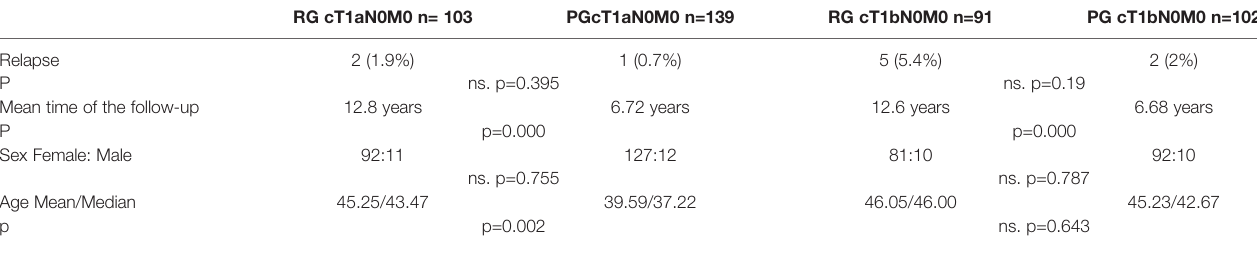
TABLE 7 | Comparison of the incidence of relapses and the mean time of the follow-up and distribution of sex and age in prospective and retrospective groups. RG cT1aN0M0 n= 103 PGcT1aN0M0 n=139 RG cT1bN0M0 n=91 PG cT1bN0M0 n=102 Relapse 2